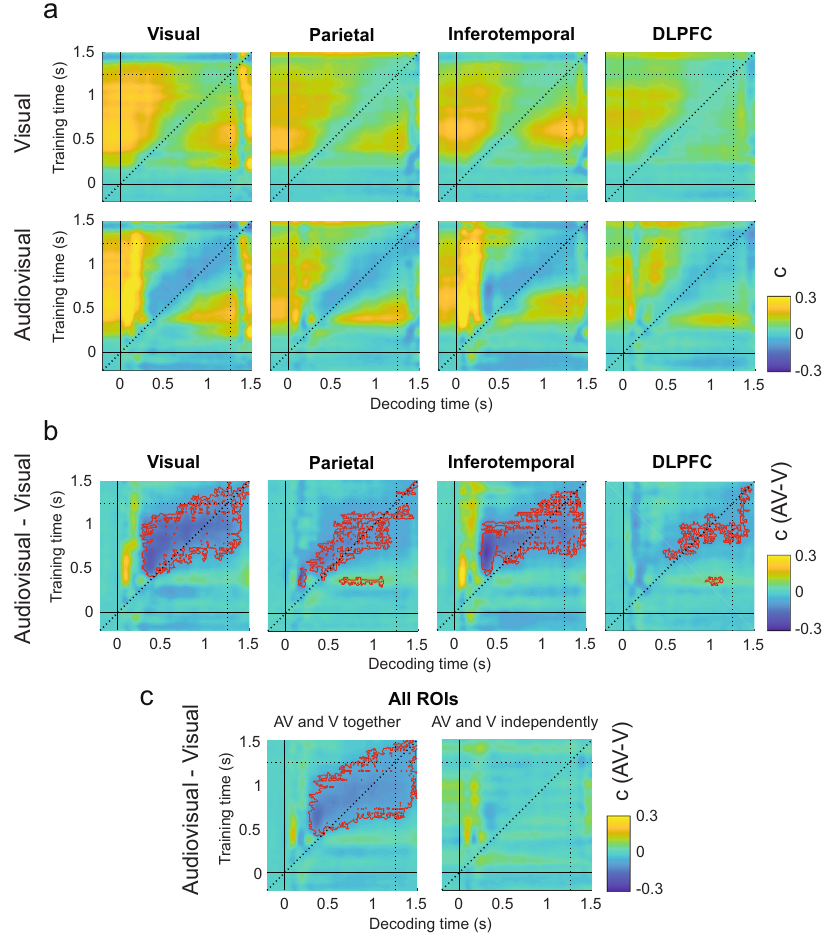
Fig. 6 Visual criterion decoded from visual and audiovisual stimuli across ROIs. Temporal generalization matrixes depict ( a ) the neural decoder ’ s criterion parameter ( c ) in the visual (upper TGMs) and audiovisual (bottom TGMs) conditions and their difference ( b ) in each ROI. c Represents the differential decoded criterion averaged over ROIs with classi fi ers trained in the visual and audiovisual conditions together (left panel) or separately (right panel). Independently trained classi fi ers fail to capture the existing differences in criterion between the audiovisual and visual conditions. Red contours delimit signi fi cant clusters. Vertical and horizontal dotted lines represent the response phase (Fig. 8). Given the null sensitivity of the decoders in classifying